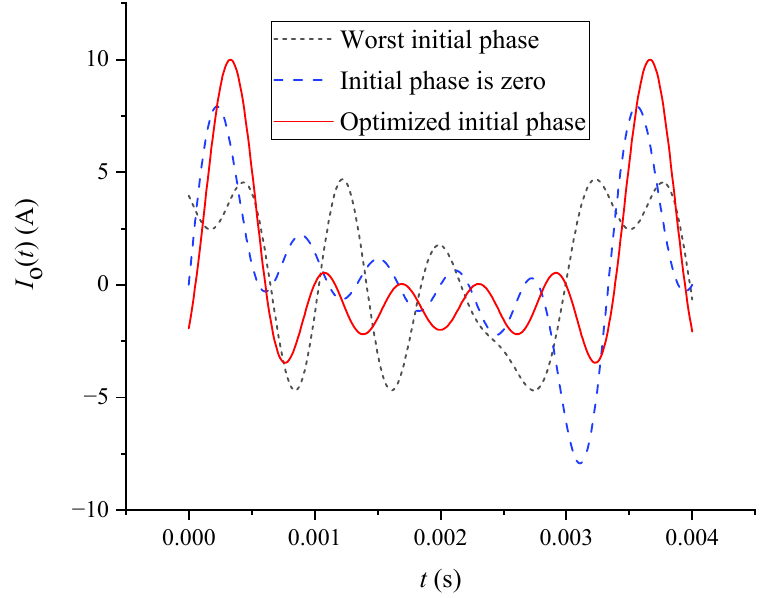
Figure 2. Excitation signals with different initial phases.